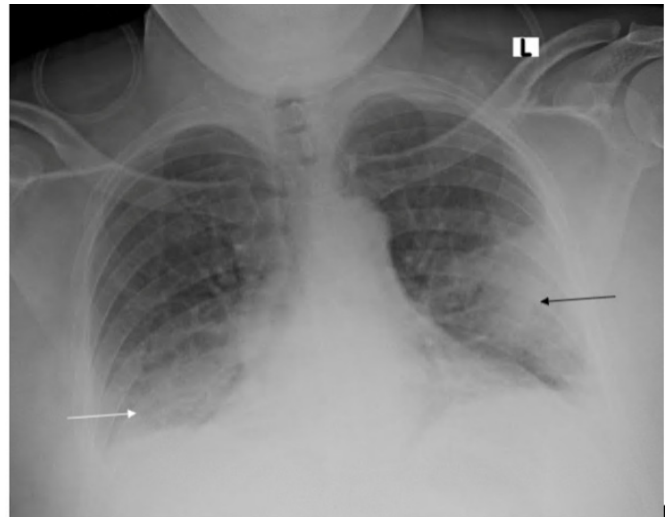
Image 2. Chest radiograph with bilateral infiltrates involving the left mid to lower lung (black arrow) and the right lung base (white arrow), suggestive of multifocal or viral